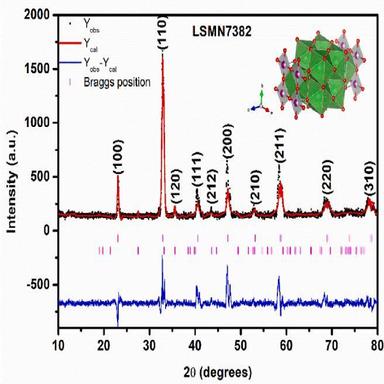
X-ray diffractogram of LSMN7382 (calcined at 1200 ◦C for 2 hr.) by Rietveld refinement method using FULLPROF.